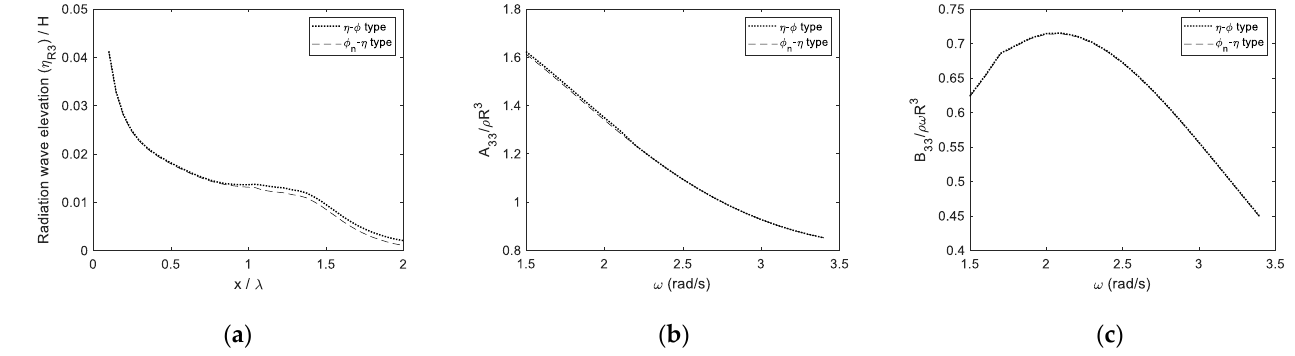
Figure 9. Comparison of the damping effects for different damping terms ( η − φ type, φ n − η type): ( a ) radiation wave elevation ( ω = 1.5 rad/s ) ; ( b ) nondimensional heave-added mass; ( c ) nondimensional heave-damping coefficient.